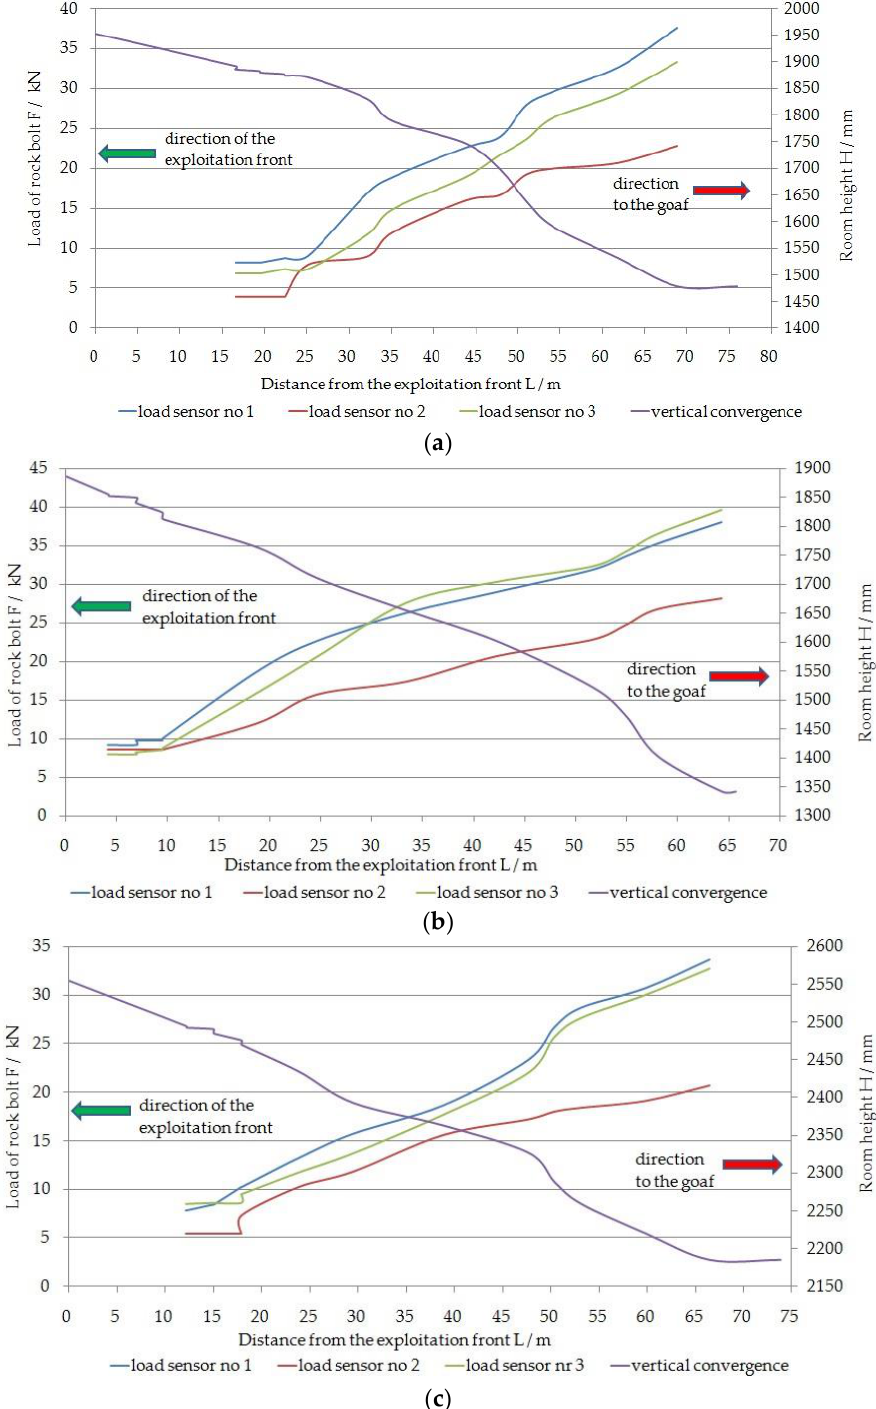
Figure 14 . Load of rock bolts and convergence in the exploitation room: (a) Room number 3; (b) Room number 26; (c) Room number